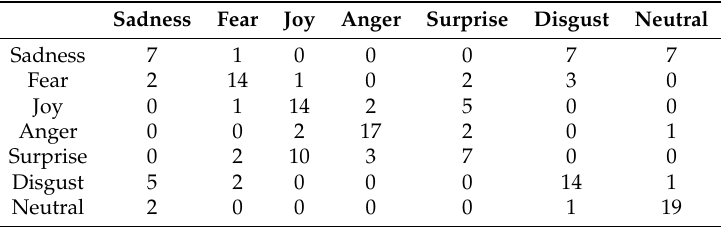
Table A14. P14 actor confusion matrix from the RekEmozio dataset in the second